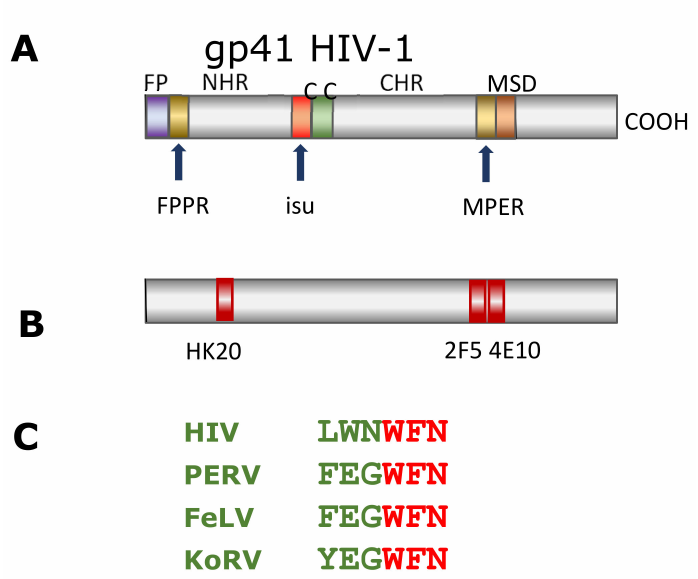
Figure 4. ( A ), Schematic presentation of the TM envelope protein gp41 of HIV-1. For abbreviations, see Figure 1. ( B ), Localization of the epitopes of broadly neutralizing monoclonal antibodies (HK20, 2F5 and 4E10) isolated from HIV-1 infected patients. ( C ), Sequence homology of the epitopes located in the MPER of the TM envelope proteins of different retroviruses, recognized by antibodies induced in species immunized with the TM envelope protein of PERV, FELV and KoRV. The epitope in the MPER of gp41 of HIV-1 is recognized by the monoclonal broadly neutralizing antibody 2F5, isolated from a HIV-1-infected